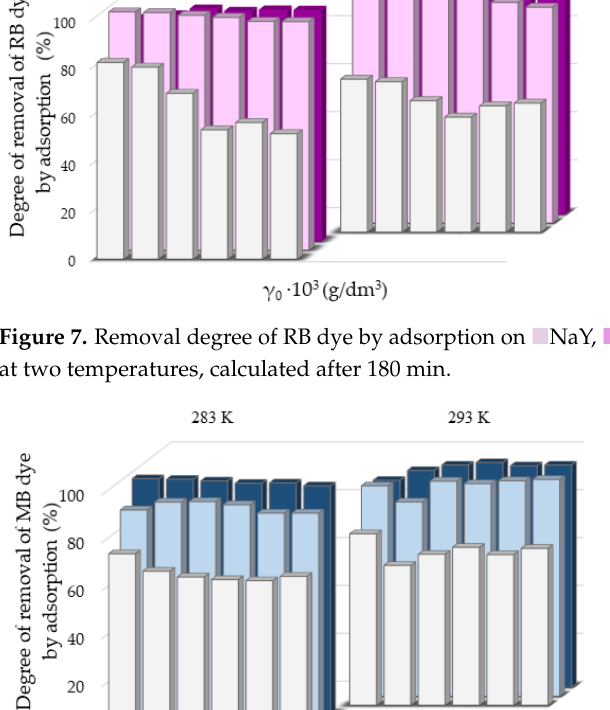
Figure 8. Removal degree of MB dye by adsorption on ■ NaY, ■ NH 4 ZSM-5, and ■ NH 4 BETA zeolites at two temperatures, calculated after 180 min.